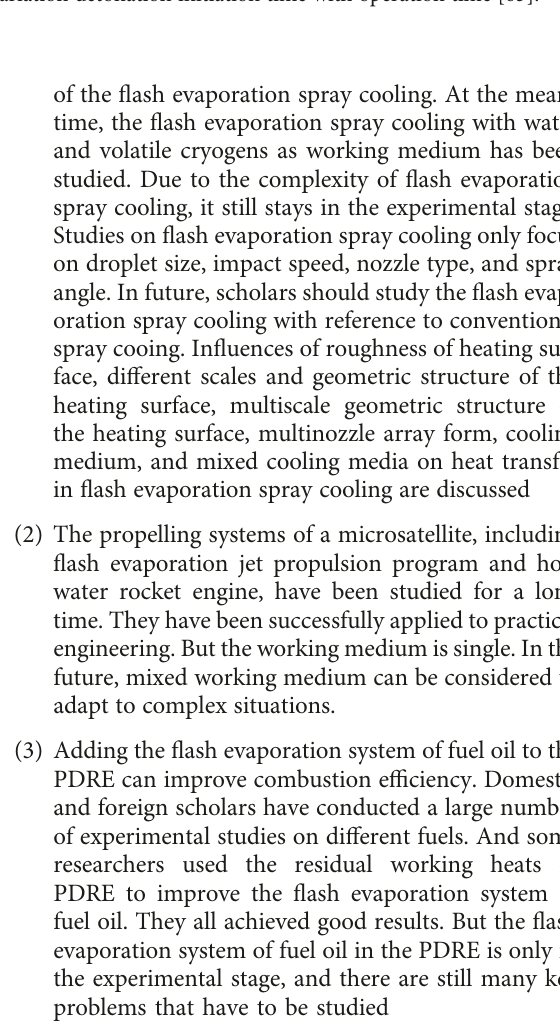
Figure 12: (a) The DDT time of the heptane and isooctane. (b) The variation detonation initiation time with operation time